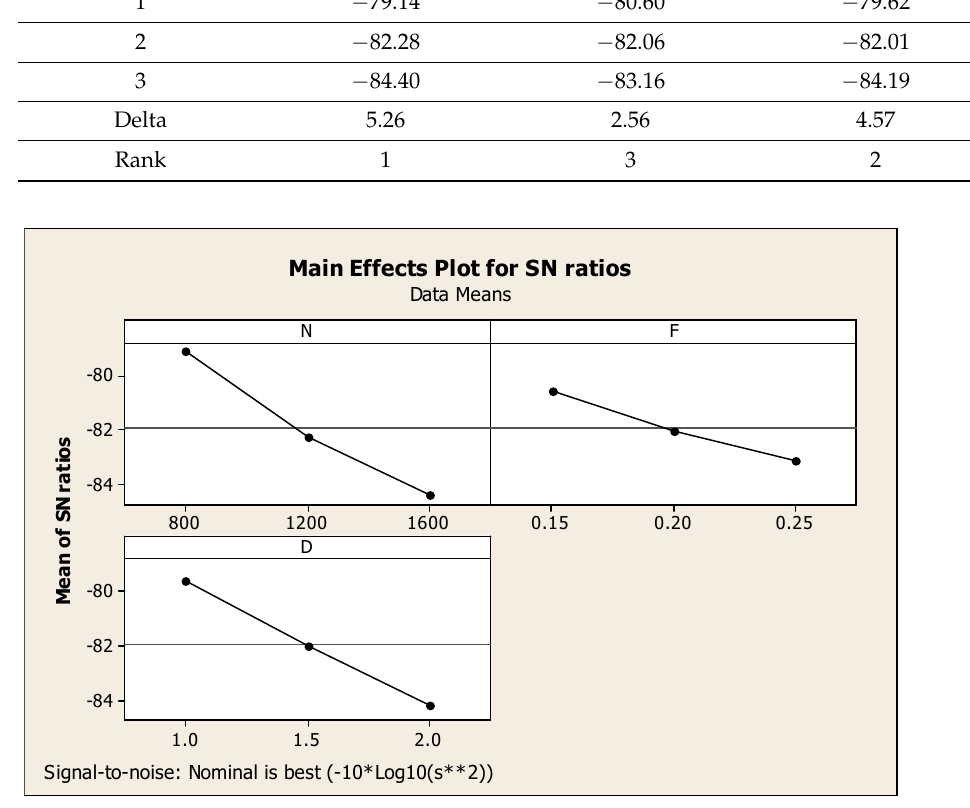
Figure 13. MRR, SR, and CF-related main effects diagram with respect to signal-to-noise ratios.